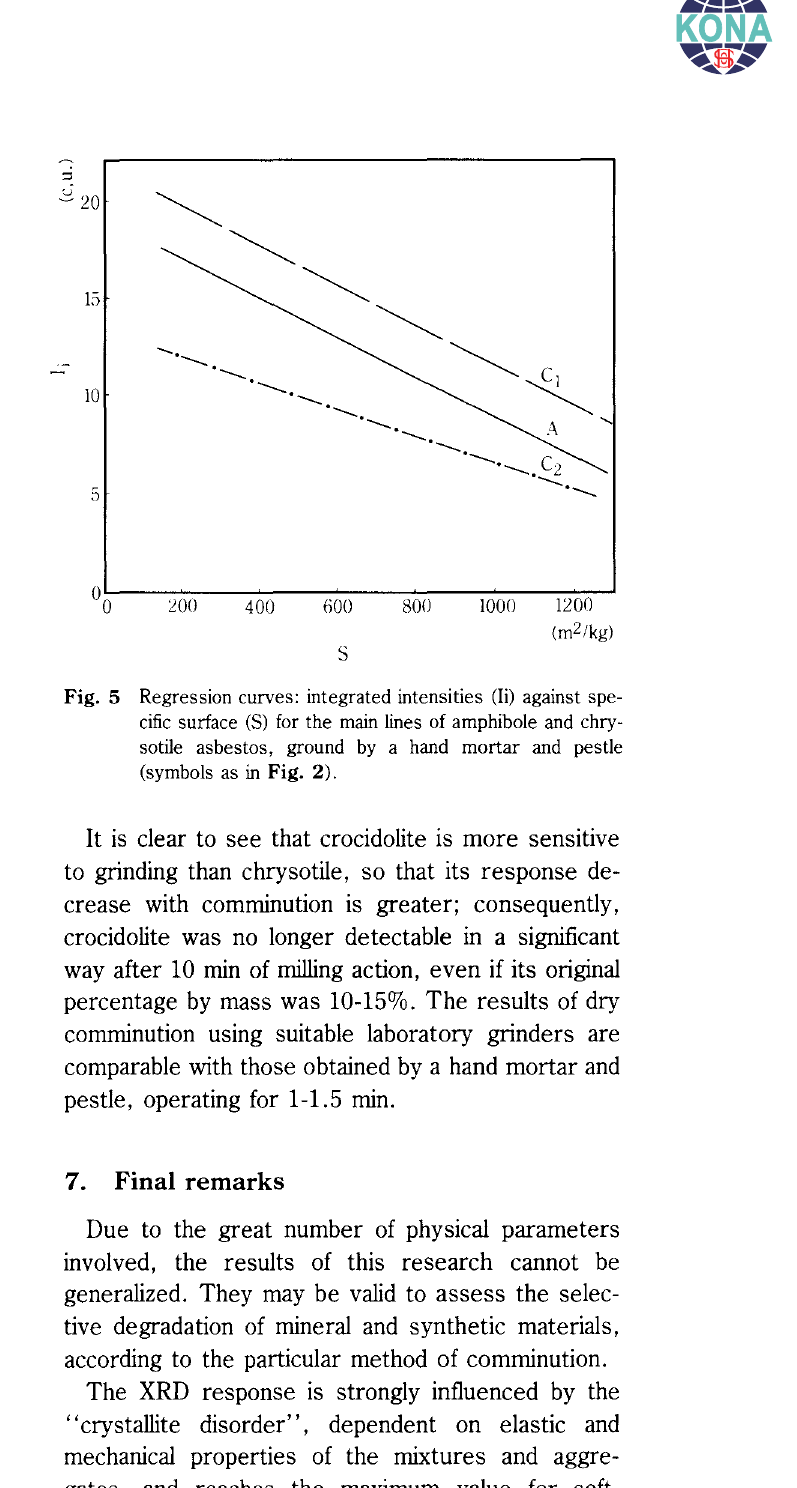
Regression curves: diffracted intensities (I) against spe cific surface (S) for the main lines of amphibole and chry sotile asbestos, ground by a hand mortar and pestle (symbols as in Fig. 2).